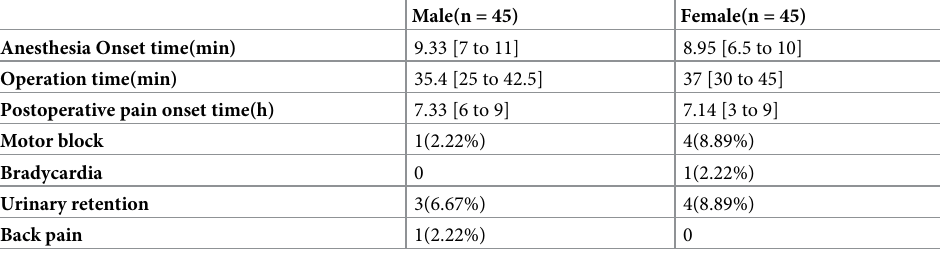
Table 3. Caudal epidural block characteristics and block complications of successful caudal